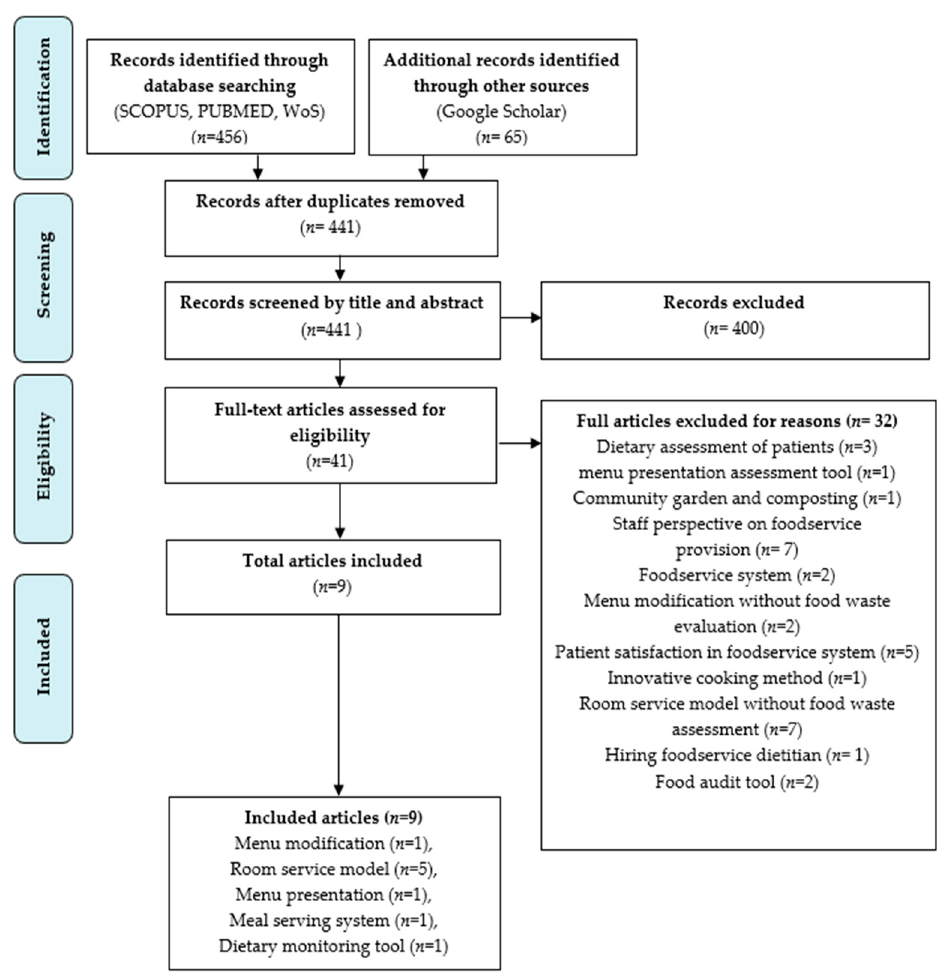
Figure 1. The original preferred reporting items for systematic reviews and meta ‐ analyses for the scoping review process (PRISMA ‐ ScR) flow diagram [20].